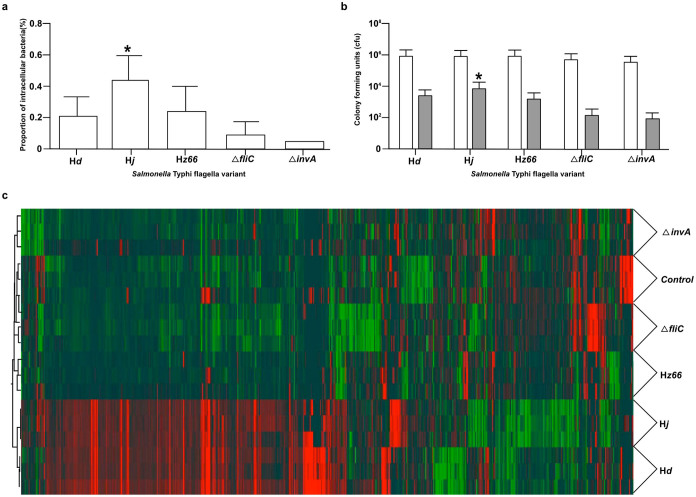
The interaction of S. Typhi flagella derivatives with epithelial cells.Hep-2 cells were infected with S. Typhi expressing one of three flagellin variants, a non-flagellated mutant (ΔfliC), and an invasion deficient mutant (ΔinvA). (a) Histogram showing the median proportion of recovered intracellular bacteria normalized by the inoculum and averaged over six experiments (*p = 0.0002, for Hj compared to other variants by ANOVA). Error bars show 1 standard deviation from the mean. (b) Histogram showing the number of recovered bacteria during attachment (white columns) and invasion (grey columns) assays averaged over six experiments (*p = 0.0001, for Hj compared to other variants by ANOVA). (c) Transcriptome analysis of infected Hep-2 cells. Figure shows hierarchical clustering of differentially expressed genes in Hep-2 cells infected with S. Typhi expressing one of the three flagellin variants, the non-flagellated mutant (ΔfliC), and the invasion deficient mutant (ΔinvA), compared with uninfected Hep-2 cells. The cut-off for differentially expressed genes was an absolute fold change >2 and FDR corrected p-value of <0.05. Red/green color scale indicates level of gene expression, red indicates increased gene expression, and green indicates reduced gene expression.